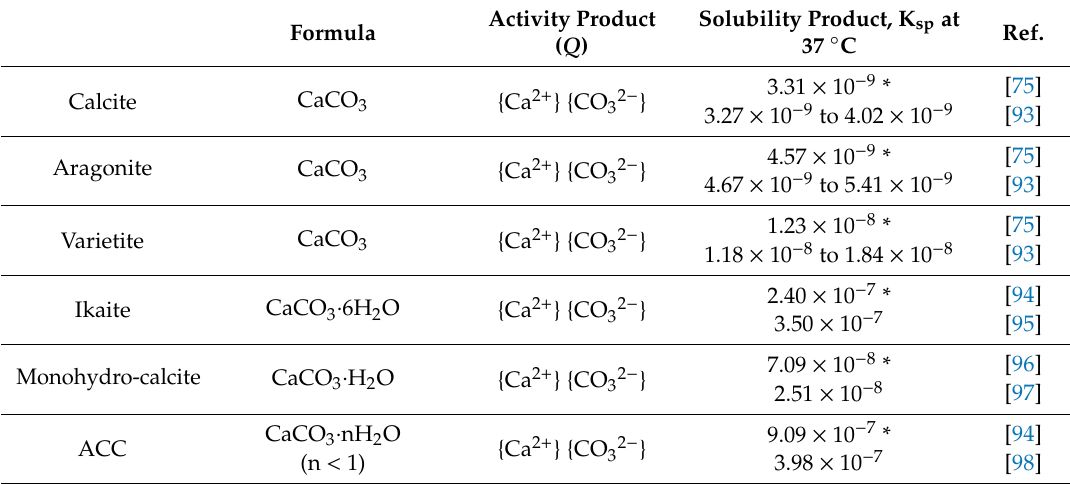
Table 2. The precipitation of insoluble calcium carbonates. The activity products (IAP) and the solubility products K sp (at 37 ◦ C) are obtained from the